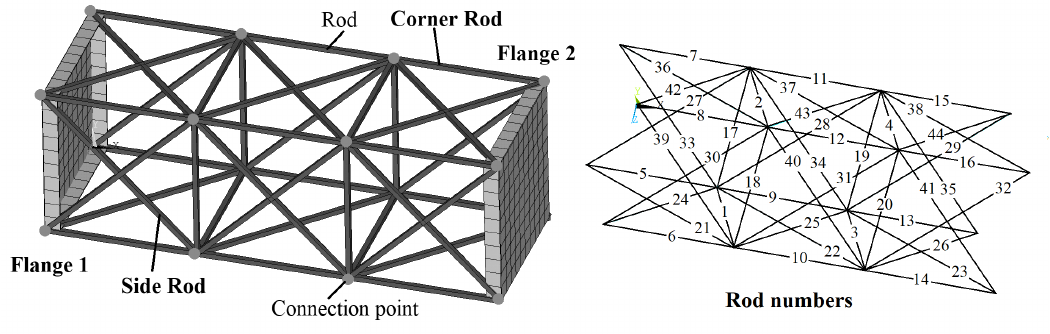
Figure 4. The truss structure of the arm.